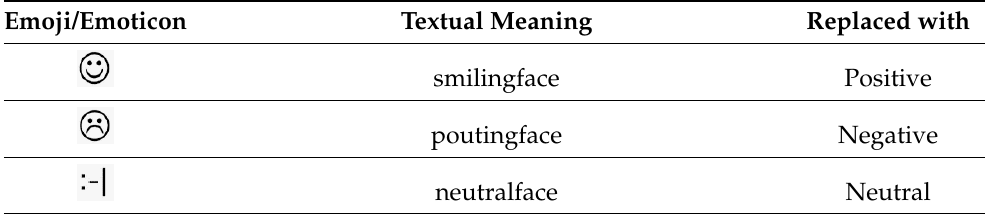
Table 1. Emoji and Emoticons conversion